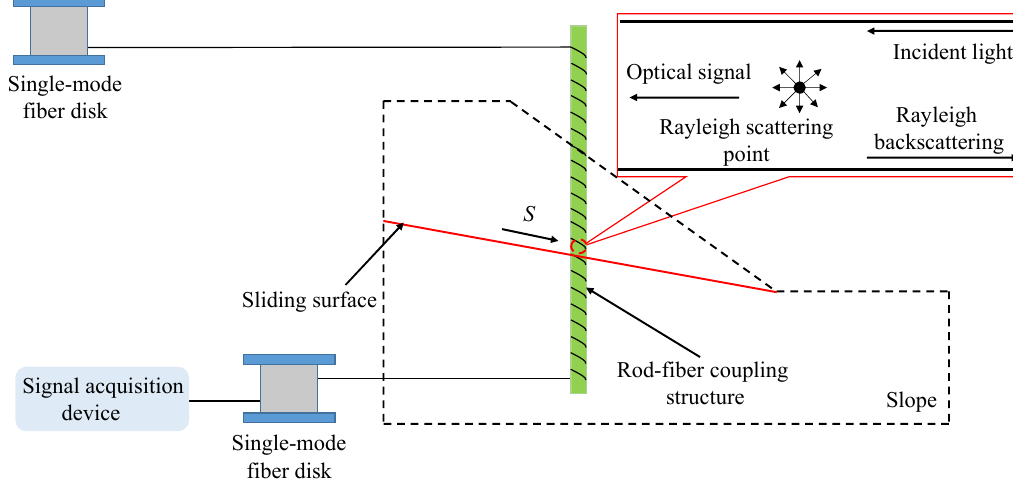
Figure 3. Measurement principle of deep displacement of slopes.